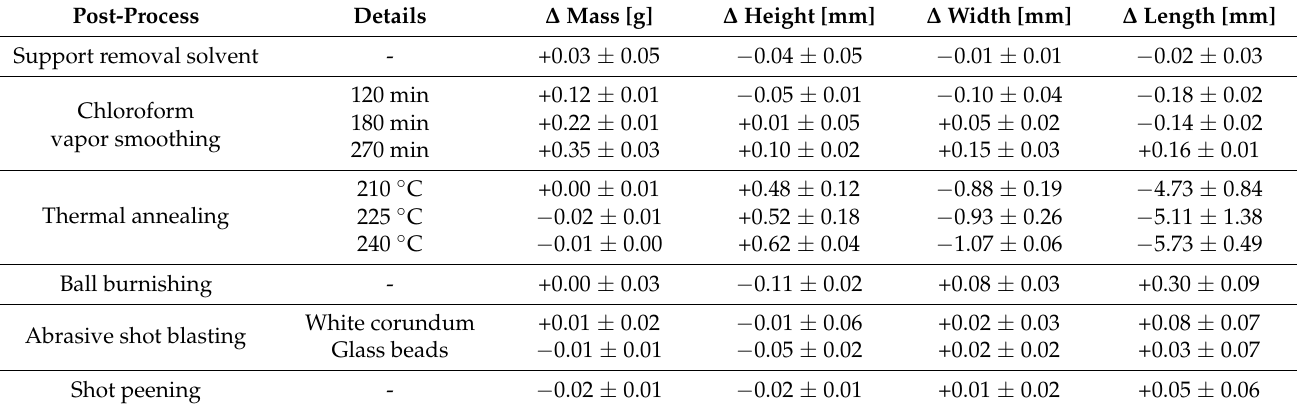
Table 2. Mass and dimensional changes as a function of the post-processing